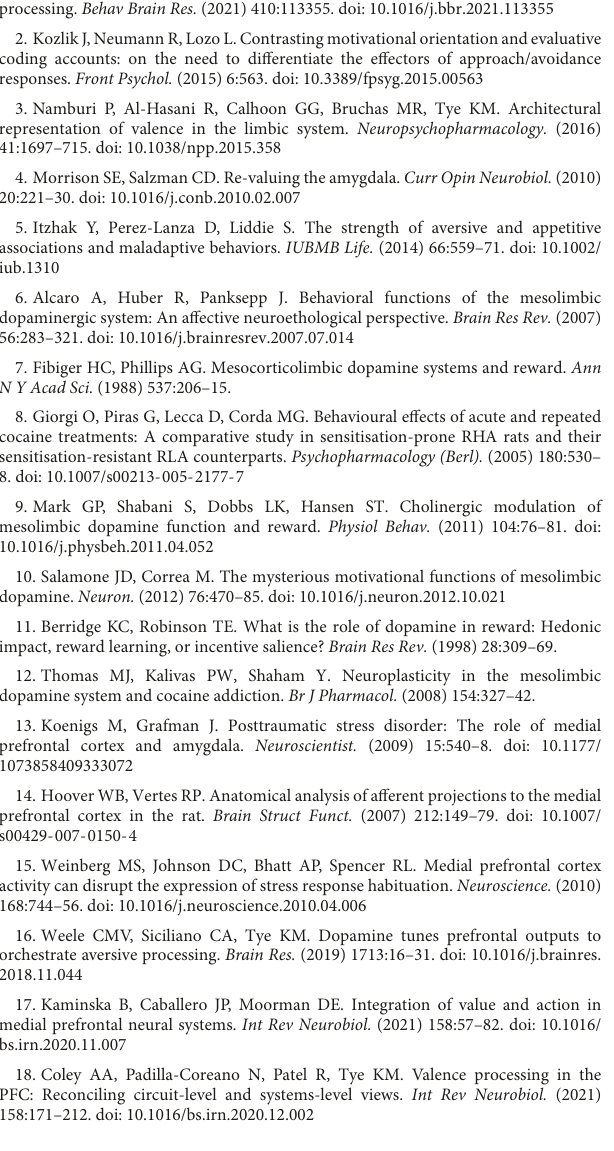
SUPPLEMENTARYFIGURE1 Optogenetic verification of Cg1, PrL, and IL photostimulation. (A) Left: the brain atlas depicting the locations of optical stimulation in the Cg1, PrL, and IL. Right: AAV virus infection with the CaMKII promotor in fluorescent green, c-Fos expression in red, and merged CaMKII and c-Fos expression in the Cg1, PrL, and IL. White boxes indicate c-Fos expression neurons with photostimulation in the Cg1, PrL, and IL. c-Fos expression neurons are indicated with arrowheads in the upper square images. (B) The location of the buried optical fibers. Blue spots indicate the Cg1 optical stimulation location, orange spots indicate the PrL optical stimulation location, and